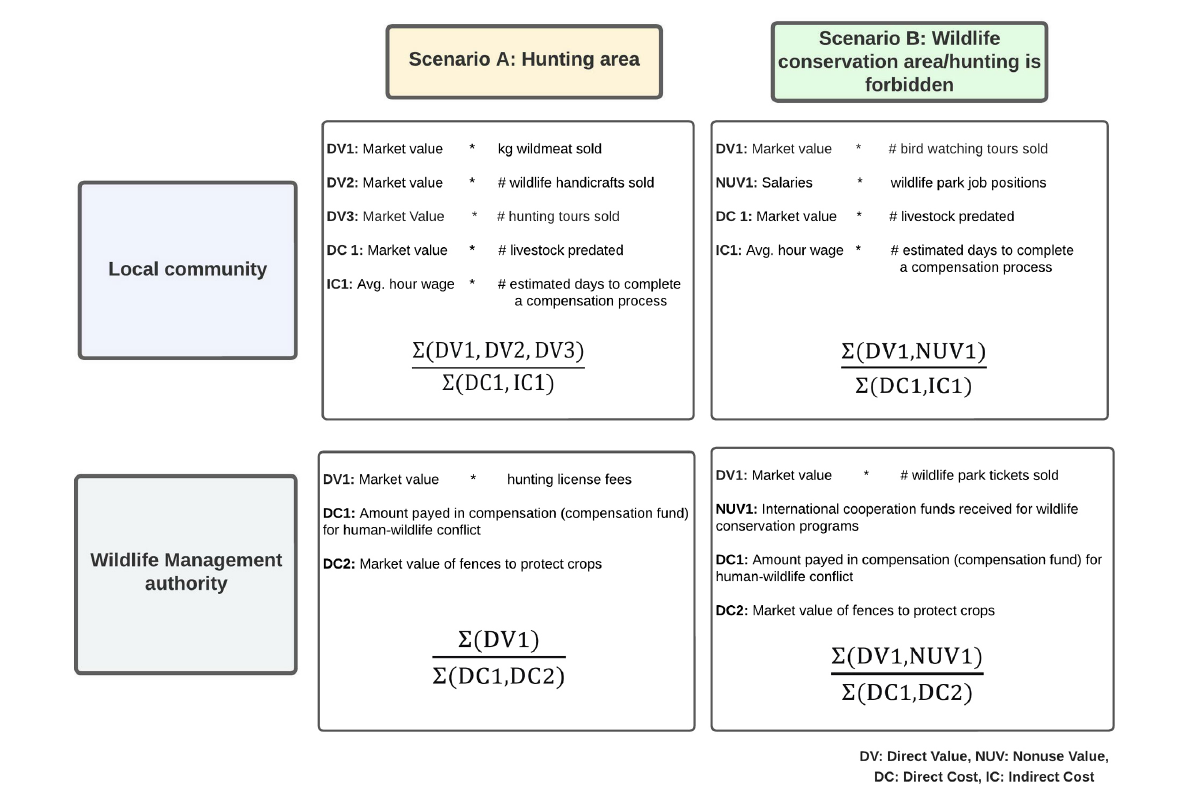
Fig. 2 . Perception of values and costs for different stakeholders in two